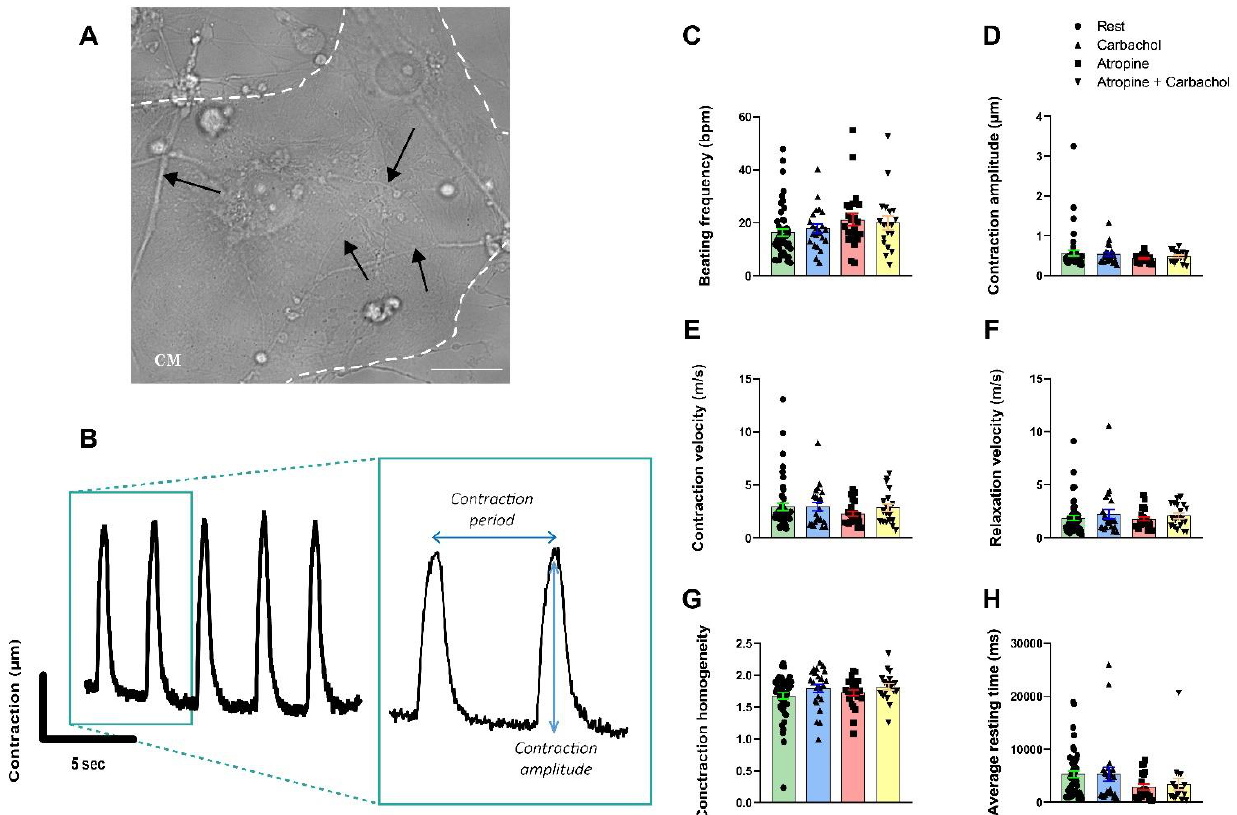
Figure 5. Contractile properties of hiPSC-CMs recorded in 14-day-old neuro–cardiac OOC by video- edge capture. ( A ) Picture of PC12 neurites connected (marked with black arrows) to hiPSC-CMs in transmitted light. Spontaneous contraction is recorded on cardiac compartment for 25 seconds. ( B ) Representation of contraction/relaxation cycle obtained from movies. ( C–H) Measurement of contractile parameters on neuro–cardiac OOC at rest, in the presence of 1.5 mM of Carbachol, 1 µM of Atropine, or in the presence of both. ( C ) Beating frequency, ( D ) amplitude of contraction, ( E ) contraction and ( F ) relaxation velocity, ( G ) contraction homogeneity and ( H ) average resting time are obtained from series of images as shown in Figure 5A. Data are presented as mean ± SEM, Rest n = 49, Carbachol n = 23, Atropine n = 23, Carbachol + Atropine n = 19, Dunn’s multiple comparisons test were